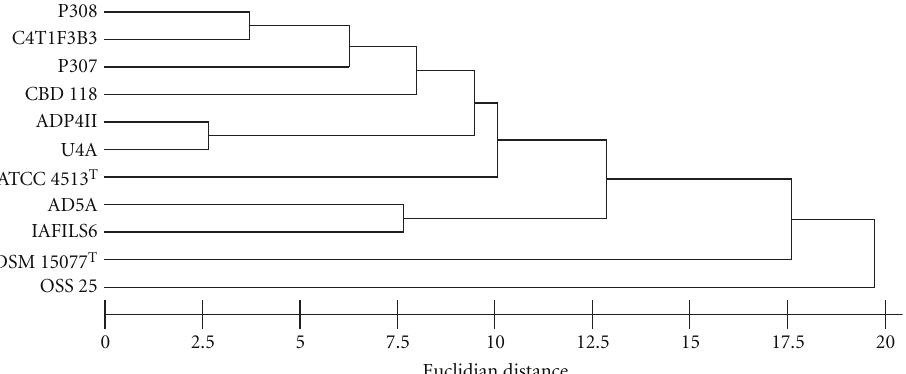
Figure 3: Dendrogram based on cluster analysis of cellular fatty acid composition for 11 Bacillus strains including B. circulans ATCC 4513 T and B. nealsonii DSM 15077 T , in Euclidian Distance units.